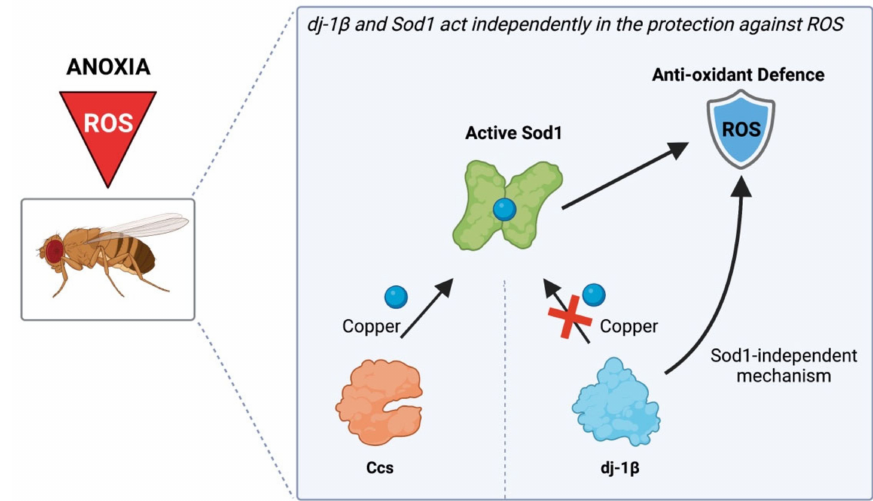
Figure 4. Proposed model describing the independent actions of Sod1 and dj-1 β in the protection against anoxia. In Drosophila melanogaster , Ccs is responsible for copper loading into the Sod1 active site through the so-called Ccs-dependent Sod1 maturation pathway. The loss of Ccs increases the susceptibility of flies to oxidative stress. dj-1 β does not participate in the Ccs-independent Sod1 maturation pathway, as in a Ccs null genetic background, dj-1 β overexpression does not induce any protection. The loss of dj-1 β increases the susceptibility to oxidative stress without affecting the Ccs-related Sod1 maturation pathway, as Sod1 levels in dj-1 β knock-out flies are similar to controls. Moreover, dj-1 β protection appears independent from Sod1 as the modulation of dj-1 β expression does not affect Sod1 levels either under basal conditions or in the presence of oxidative stress (created with BioRender.com, accessed on 7 July